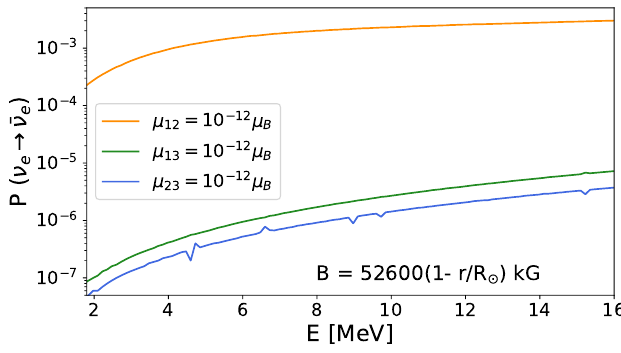
Figure 4 . Electron antineutrino appearance probability on the Earth as a function of neutrino energy for nonzero µ 12 , µ 13 and µ 23 , for the AGSS09 solar model. Evolution equations were solved